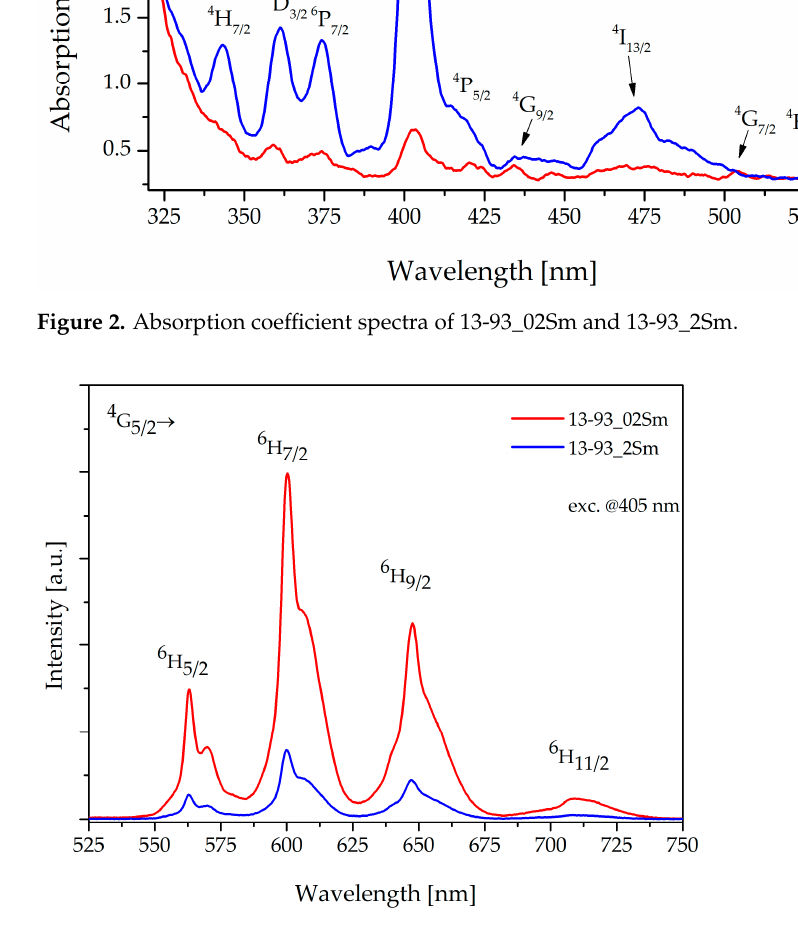
Figure 4. Energy level diagram of Sm 3+ with emission and cross ‐ relaxation channels [18,19]. In Figure 5 we can observe the luminescence spectra of the bioactive fibers doped with various concentrations of samarium ions before and during the degradation process, at specific time intervals: 4, 8, 24, and 48 h. It is seen that optimization of Sm 3+ content allows for adjustments in sensor response as it is affected by the dissolution rates. The most intense transition, 4 G 5/2 → 6 H 7/2 (600 nm), was chosen for further experiments on bio ‐ active glass fibers.